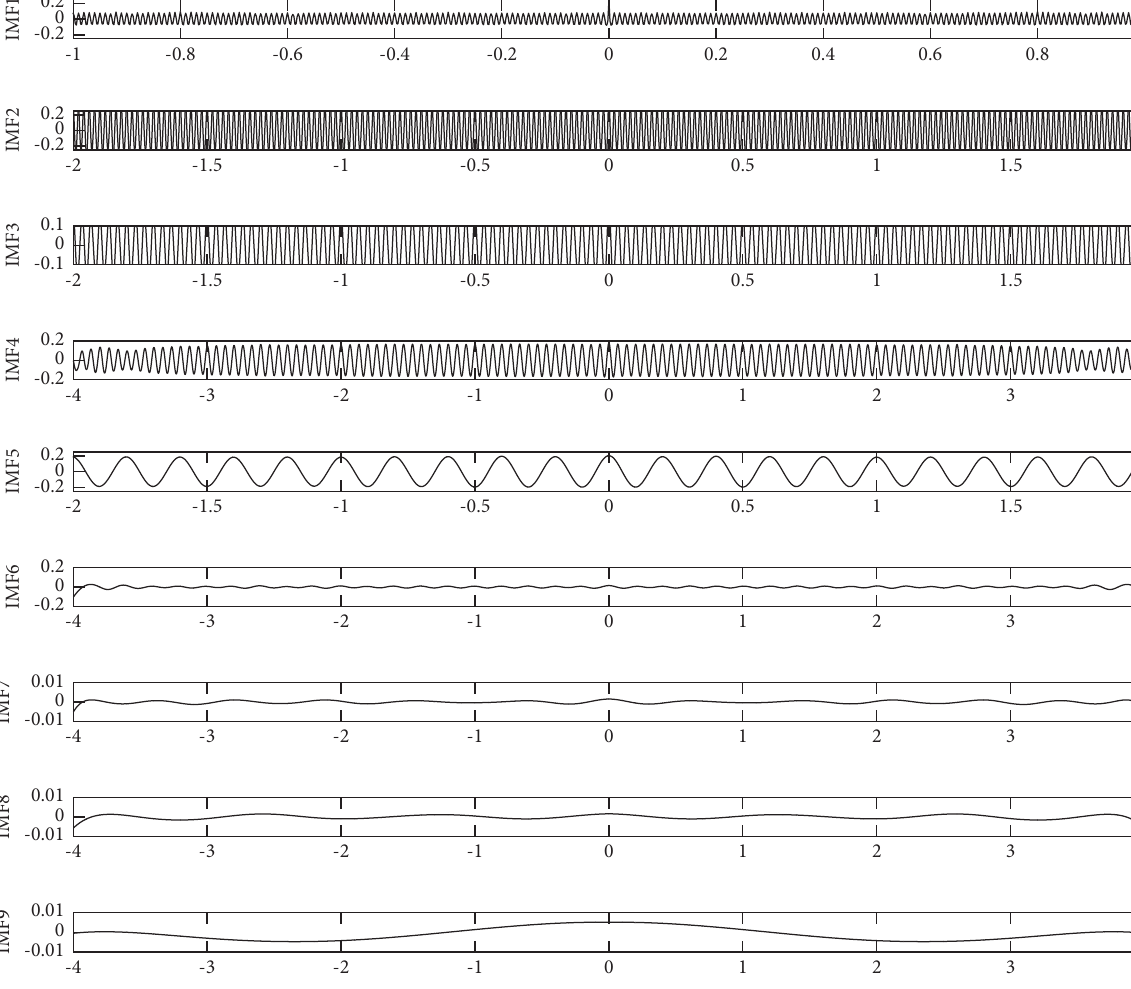
Figure 6: Autocorrelation functions of all IMF